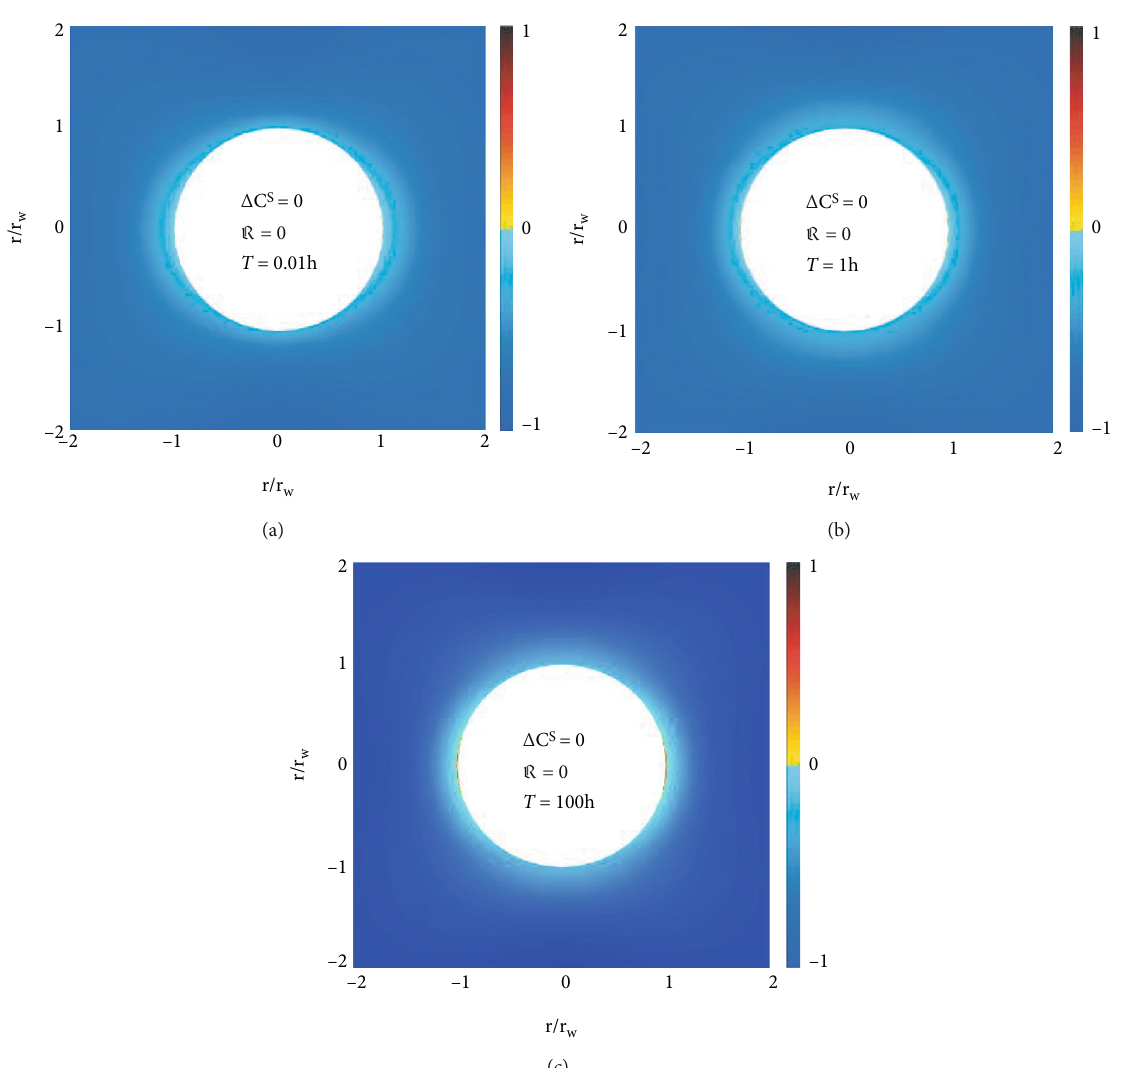
Figure 14: Damage zone around the wellbore considering hydromechanical coupling after (a) 0.01h, (b) 1 h, and (b) 100h